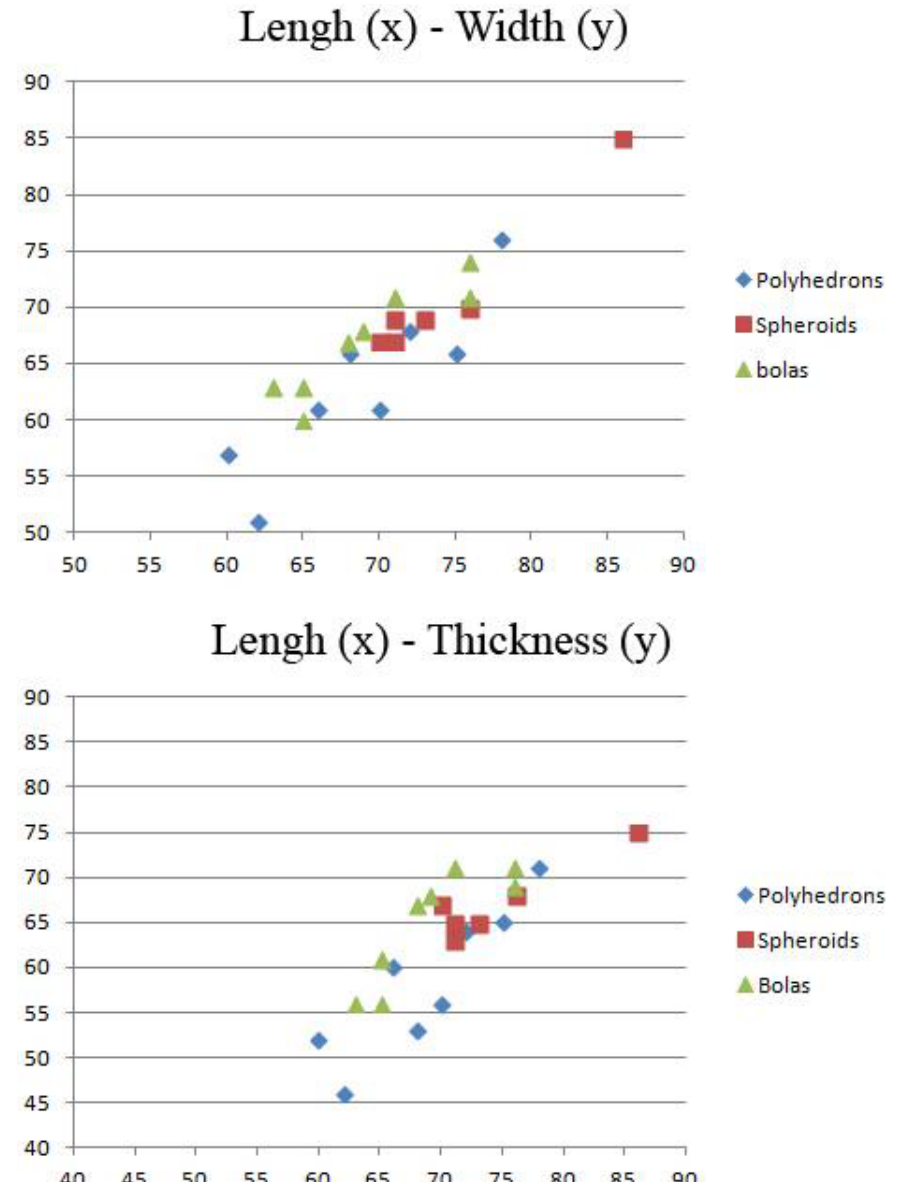
Figure 7. Length (x) / Width (y) on the left and Length (x) / Thickness (y) on the right ratio for each category